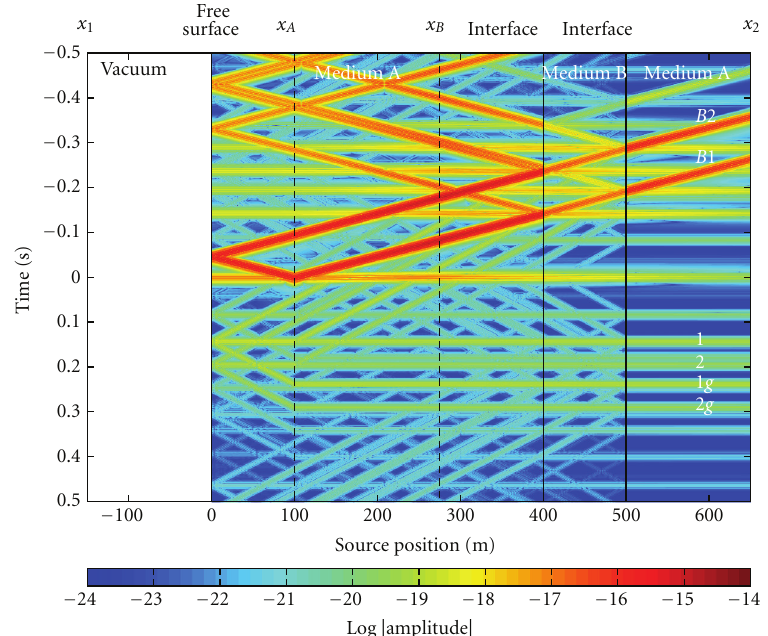
Figure 15: The obtained correlation gather of the domain integral for a three-layered medium bounded by a vacuum. The scale is taken as the logarithm of the absolute value of the amplitude. Summing this correlation gather panel yields the total contribution of the domain integral as shown in Figure 14 by the blue volume line. Several events can be